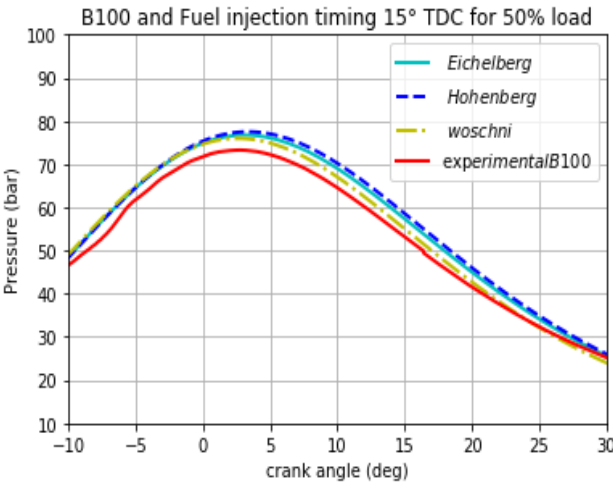
Figure 7. Cylinder pressure of B100 at 50% load.